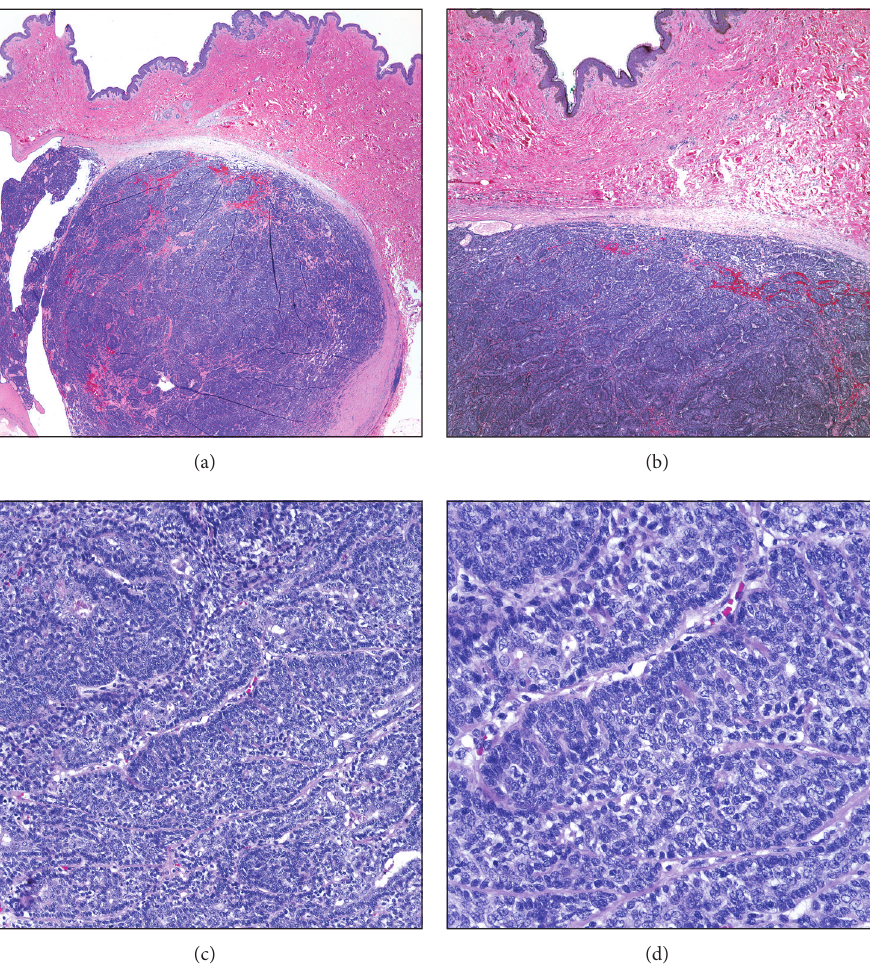
Figure 1: Eccrine spiradenoma of breast. The tumor is located at the interface of the deep dermis and superficial breast tissue, well- circumscribed with a thick fibrotic capsule (a and b). Two-cell populations within the tumor clusters are identified with dark-grey and light- grey nuclei being evident. The two-cell populations constituting this tumor: small dark and basaloid cells with hyperchromatic nuclei and larger cells with a pale nucleus, often near the center of the